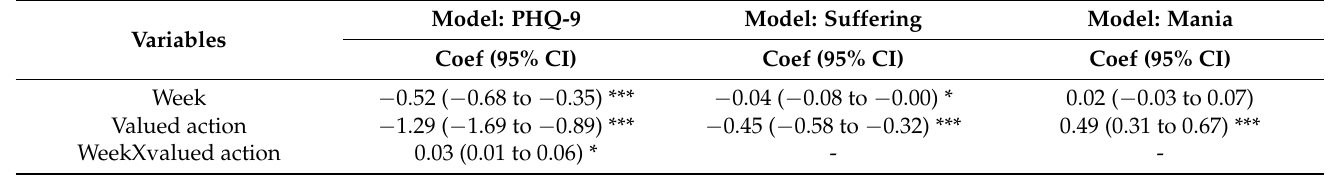
Table 5. Models for PHQ-9, Suffering and Mania predicted by value action. Model: PHQ-9 Model: Variables